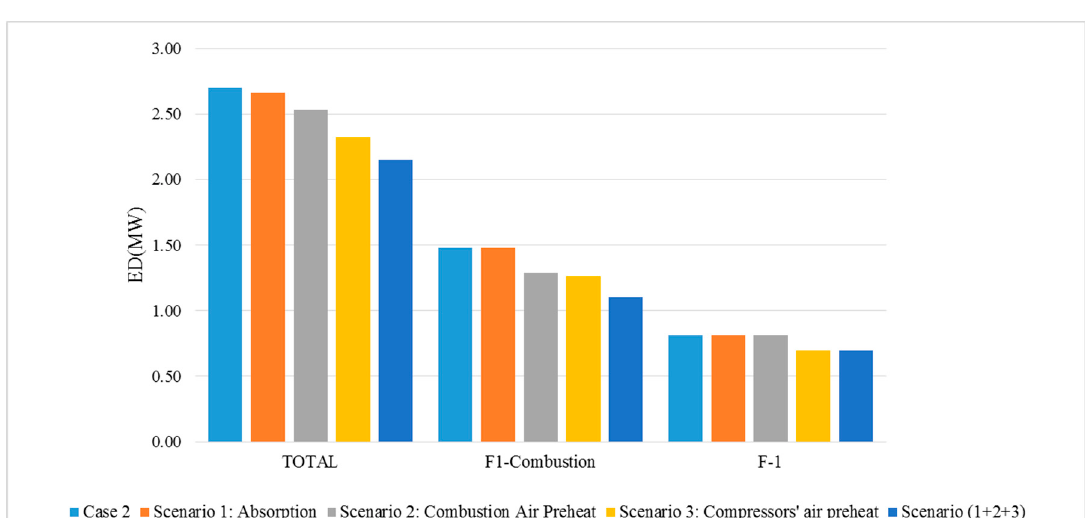
Figure 22. GCC of scenario (1 + 2 + 3).